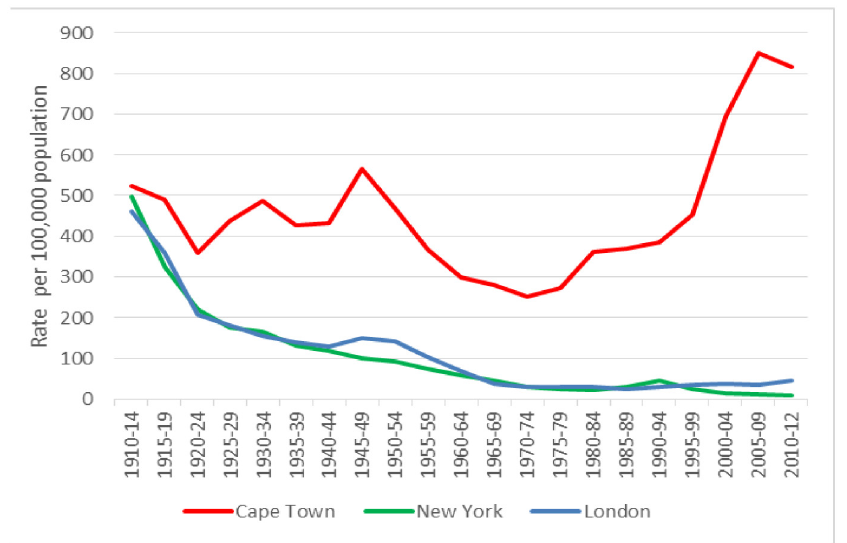
Fig 2. TB notification rates over time. The current (2009 – 2012) HIV-negative rate in Cape Town was 445 per 100,000 population, the HIV-positive rate was 6338 per 100,000 population (not shown). Note.